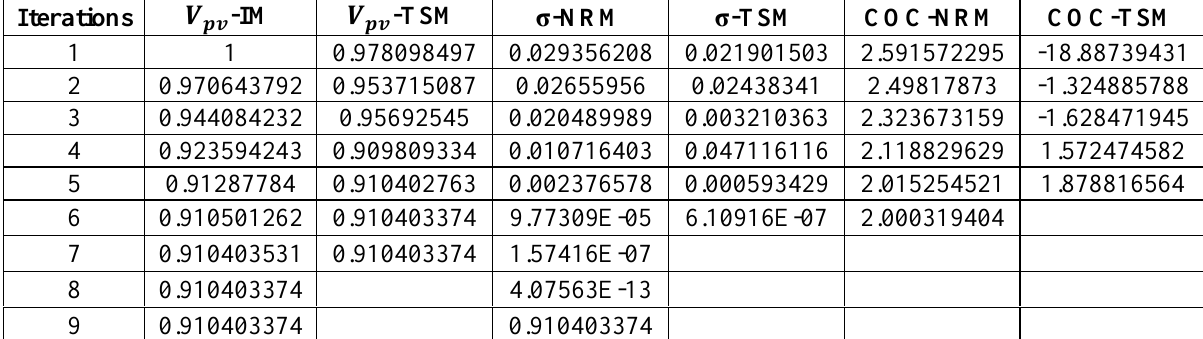
Table 3: The obtained values using NRM and